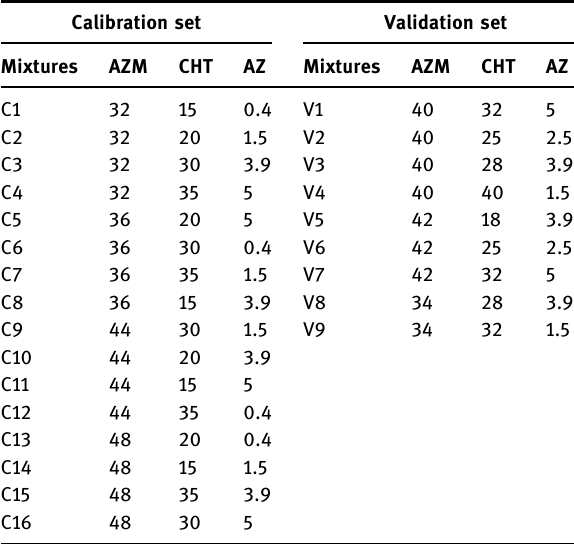
Table 1: Concentrations of AZM, CHT, and AZ ( µg mL − 1 ) in calibration and validation sets Calibration set